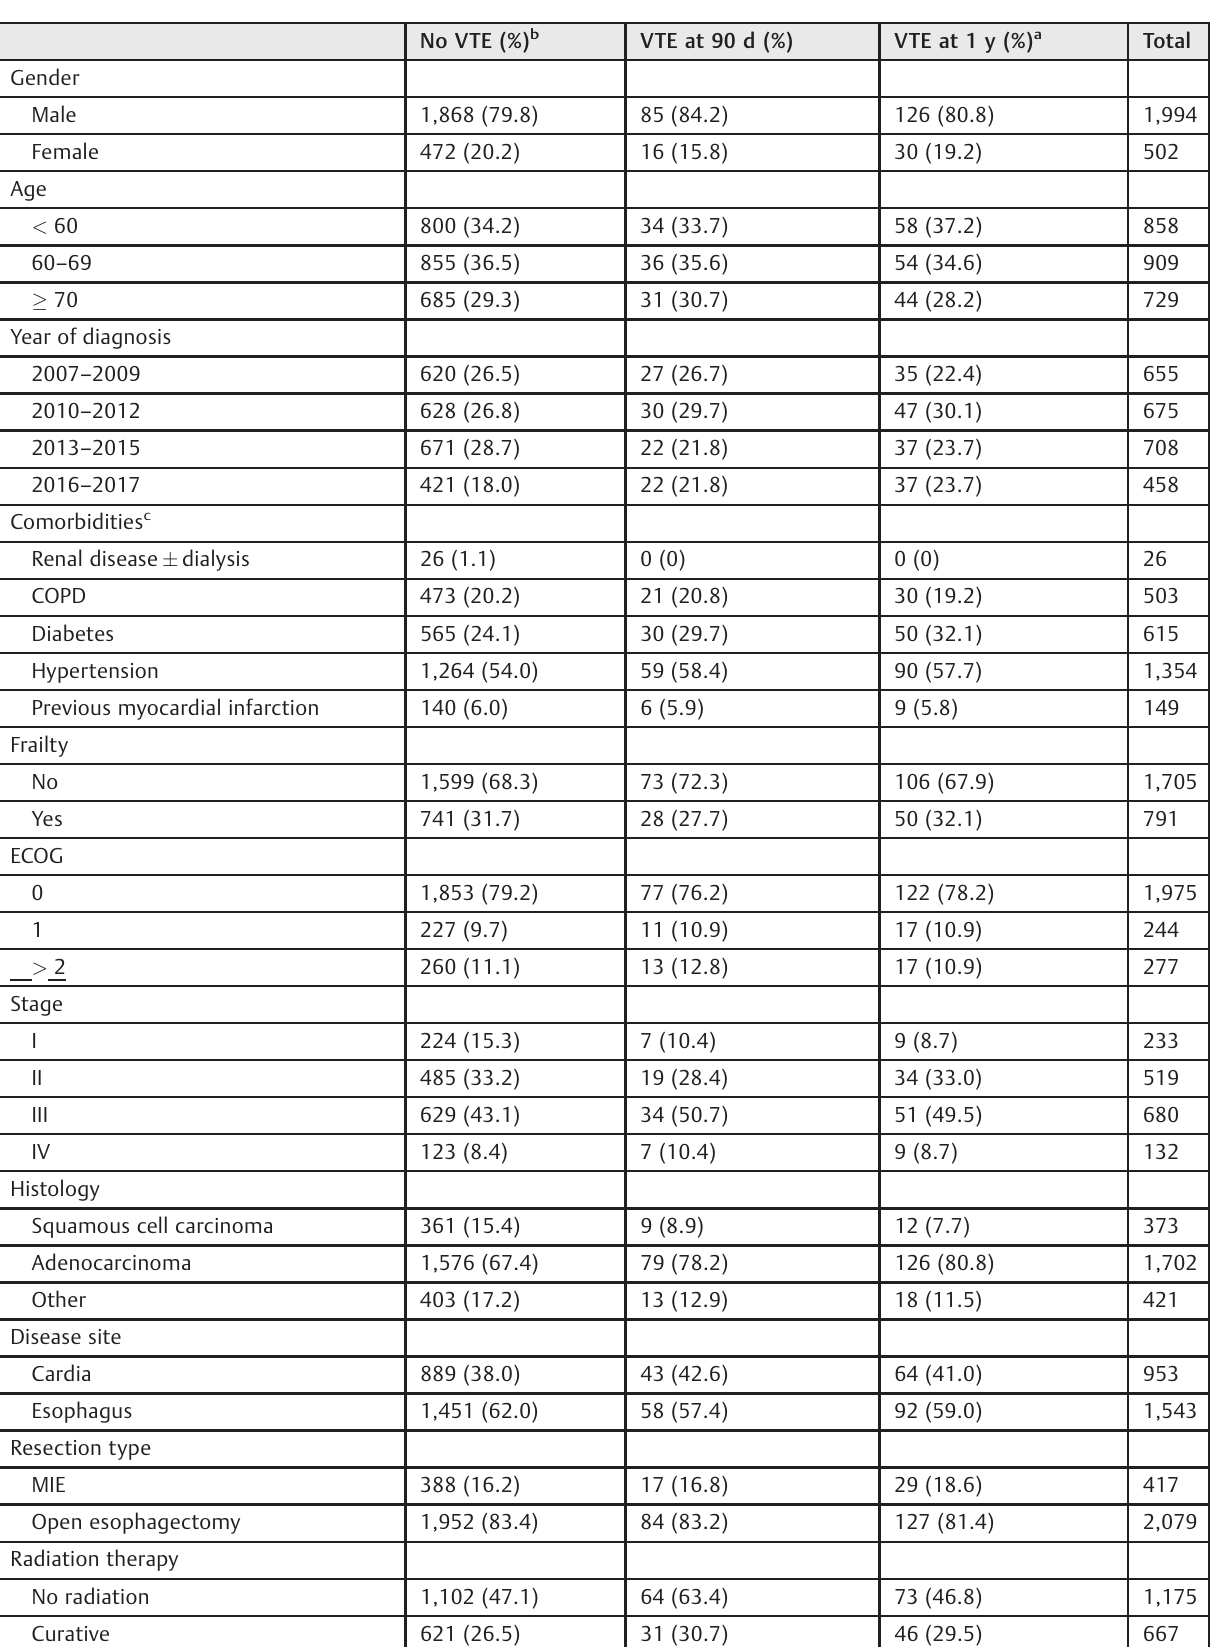
Table 1 Baseline characteristics of patients with and without a postoperative